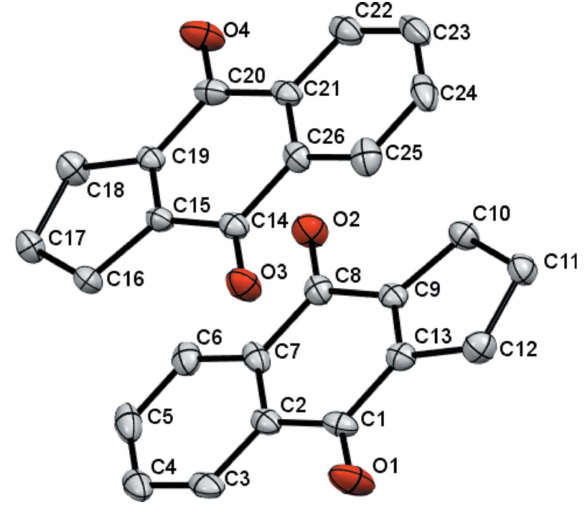
Figure 1 The molecular structure of the title compound with displacement ellipsoids drawn at the 50% level while H atoms are omitted for